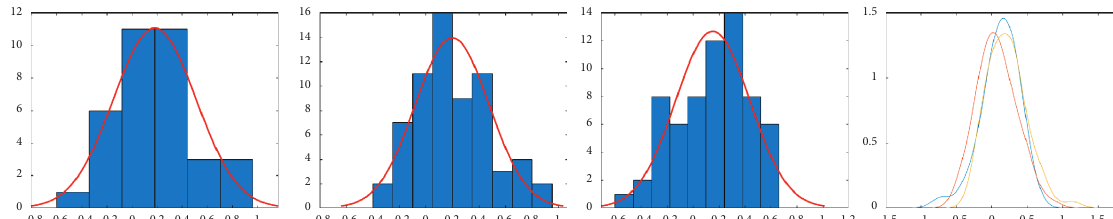
Figure 13: Standard deviation and normal distribution curve of pair 1, pair 2, and pair 3.